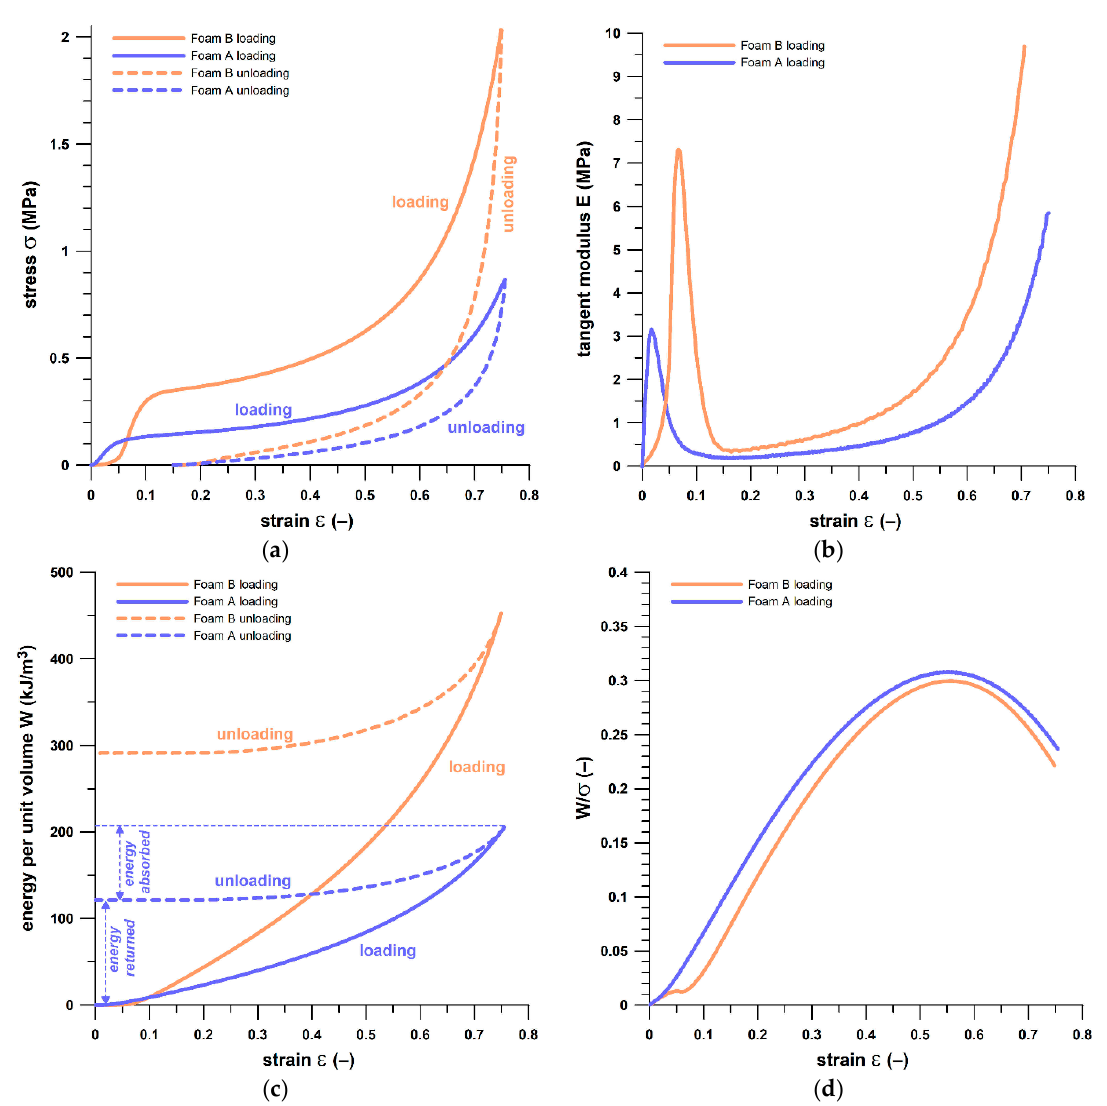
Figure 2. ( a ) Stress vs strain; ( b ) tangent modulus vs strain curves (loading segment) ( c ): energy per unit volume vs strain; ( d ) ratio of energy per unit volume to stress vs strain (loading segment) of foams A (blue) and B (pink).